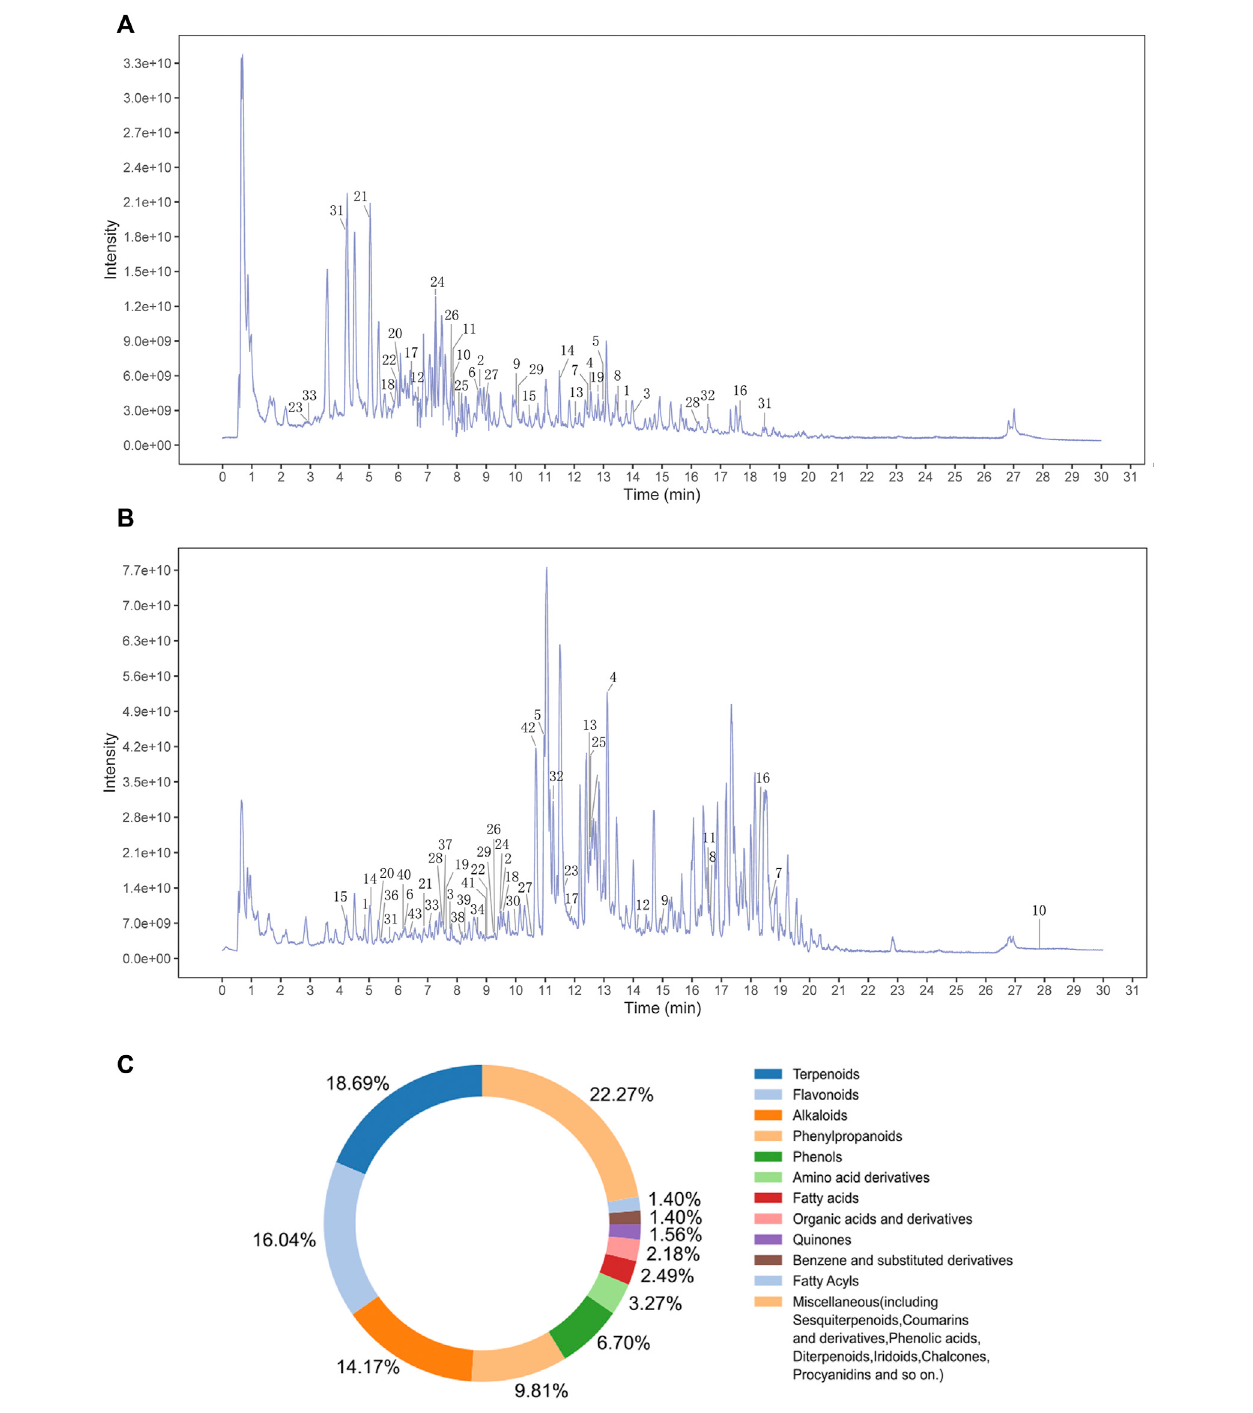
FIGURE 1 | An overview of MMQ-8 chemical components was detected by UHPLC-QE-MS assay. (A) The fi ngerprint of MMQ-8 total chemical components in NEG electrospray ionization modes. We marked 33 active metabolites screened according to the Percent Human Oral Absorption and drug likeness values (B) The fi ngerprint of MMQ-8 total chemical components detected in POS electrospray ionization modes. We marked 43 active metabolites screened according to the Percent Human Oral Absorption and drug likeness values. (C) In total, 642 chemical components of MMQ-8 were obtained, among which fl avonoids, terpenoids, phenylpropanoids, phenols, and alkaloids were the most abundant.